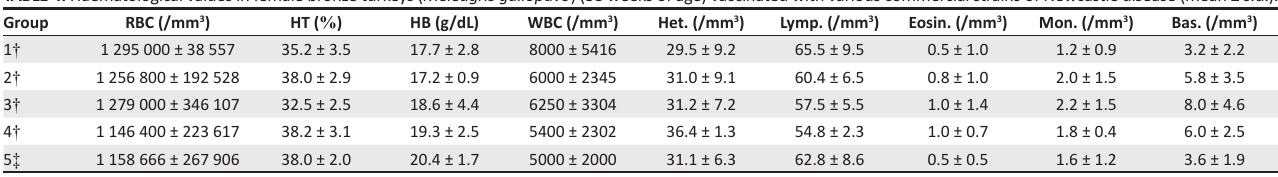
TABLE 4: Haematological values in female bronze turkeys ( Meleagris gallopavo ) (38 weeks of age) vaccinated with various commercial strains of Newcastle disease (mean ± s.d.). Group RBC (/mm 3 ) HT ( % )